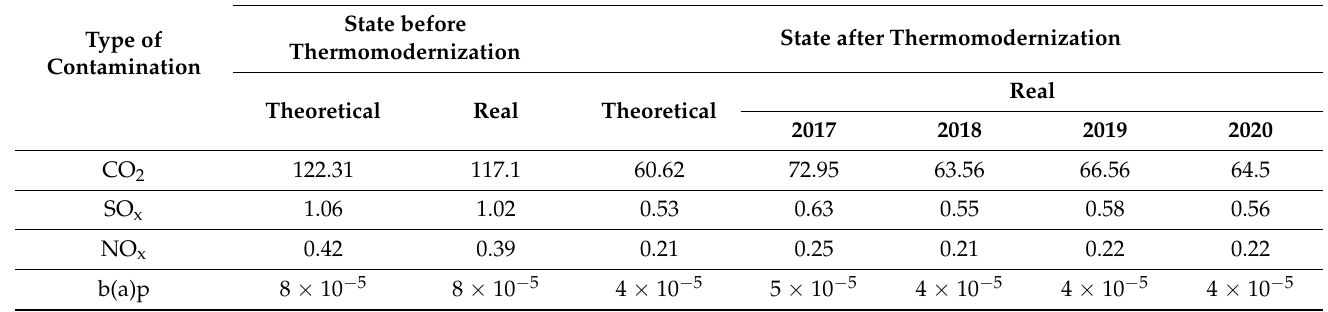
Table 12. The amount of pollutant emissions before and after thermomodernization, both the theoretical and real values